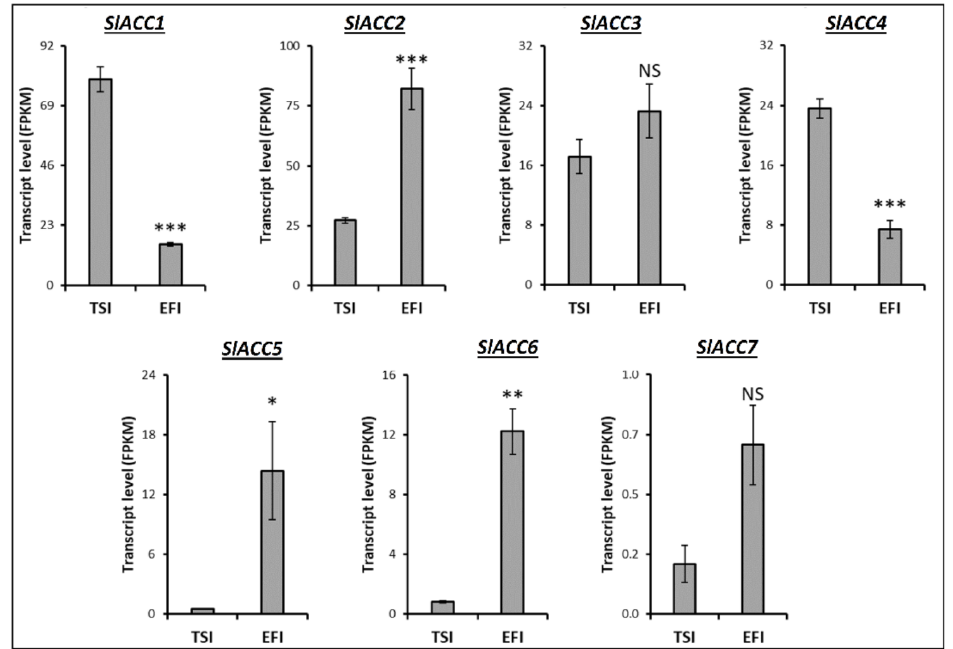
Figure 10. Effect of top sprinkle (TSI) and ebb-and-flow (EFI) irrigation on transcript profiling of ACC synthase genes in tomato roots. Vertical bars indicate means ± SE (3 biological and 3 techincal replicates). The *, ** and *** represent significance at p ≤ 0.05, p ≤ 0.01 and p ≤ 0.001, respectively, according to Student’s t -test. NS–not